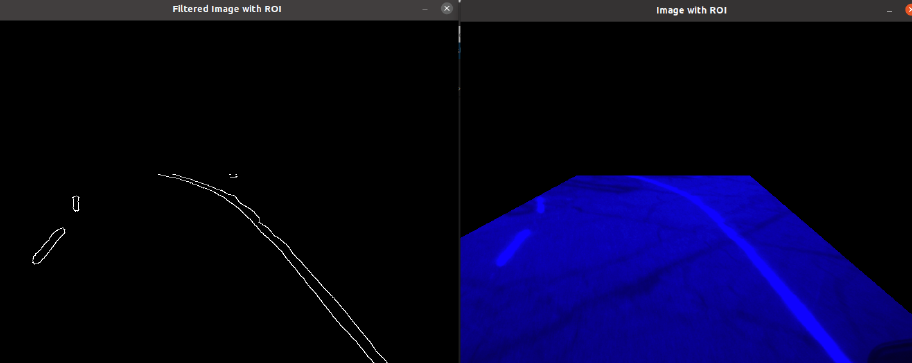
Figure 17. The above image shows the ROI used for Average Center Lane Line method for lane centering. The same ROI is used for inner and outer lane.